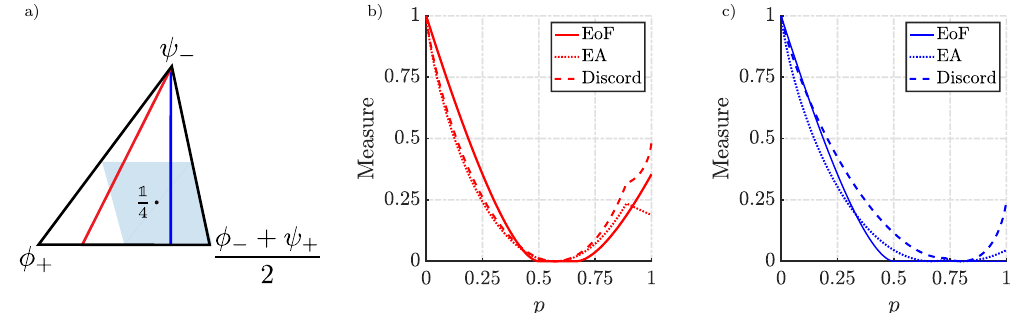
Figure 9. Variation of correlation measures along the lines in the plane shown in ( a ). p represents the distance of the state from the vertex ψ along the respective lines. The blue shaded region in ( a ) represents the separable −